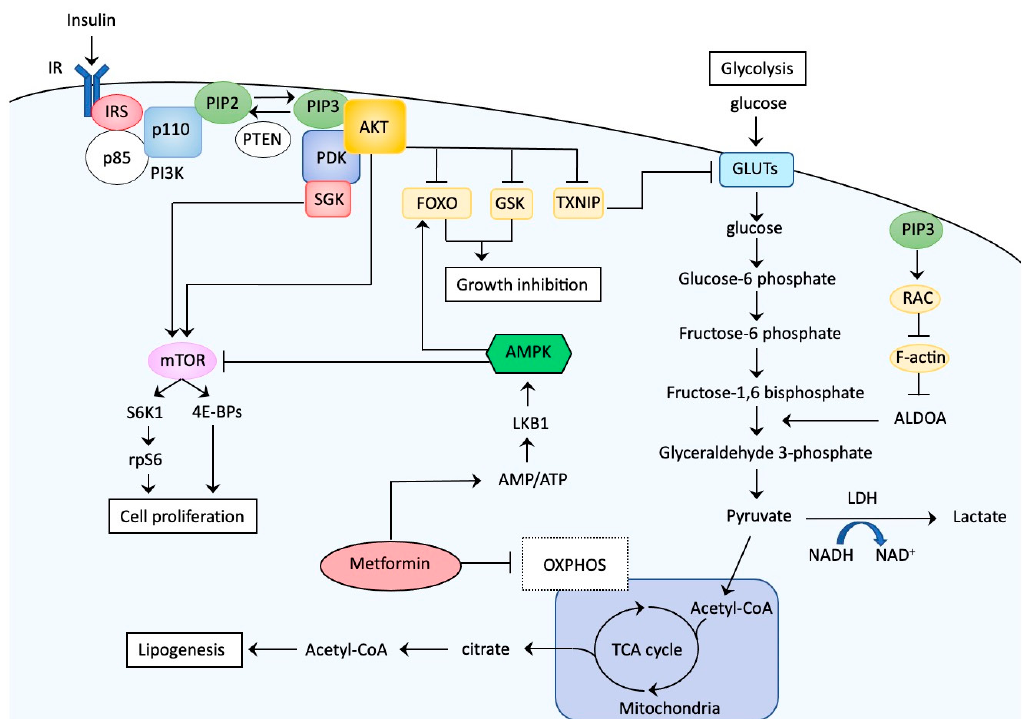
Figure 2. Insulin-PI3K signaling facilitates cell proliferation and glucose metabolism via serine/threonine protein kinase B (AKT)-dependent and -independent mechanisms. The interaction of insulin with the insulin receptor (IR) triggers phosphoinositide 3-kinase (PI3K)-regulated signaling, in which phosphatidylinositol 3,4,5-triphosphate (PIP 3 ) recruits phosphoinositide-dependent kinase 1 (PDK1), the serine/threonine kinase AKT, and other factors to the cell membrane where the signals are propagated via a series of serine/threonine kinase and tyrosine kinase activities. Phosphatase and tensin homologue (PTEN) can dephosphorylate PIP3 to form PIP2, limiting activation of this pathway, and loss-of-function mutations in PTEN cause significant elevations in PIP3, a driving force of this pathway. Phosphorylated AKT inhibits downstream targets via phosphorylation, including forkhead box protein O (FOXO)-1 and glycogen synthase kinase (GSK), both of which normally function to inhibit cell growth. Phosphorylated AKT also inhibits thioredoxin-interacting protein (TXNIP), an adaptor for endocytosis of glucose transporters (GLUTs), leading to dissociation from the GLUTs, inhibition of their endocytosis, and rapid glucose uptake upon insulin stimulation. AKT phosphorylation leads to activation of mammalian target of rapamycin (mTOR), a protein kinase that controls cell proliferation via activation of the eukaryotic initiation factor 4E-binding protein-1 (4E-BP-1) complex and S6 kinase 1 (S6K1), which phosphorylates ribosomal S6 protein (rpS6). Insulin-PI3K signaling also activates an AKT-independent pathway, in which PIP 3 -recruited Ras-related C3 botulinus toxin substrate (RAC) activation leads to disruption of the actin cytoskeleton and release of filamentous actin (F-actin)-bound aldolase A (ALDOA), resulting in aldolase activation that promotes the glycolysis pathway. Additionally, PI3K signaling activates serum and glucocorticoid-induced protein kinase (SGK1) via